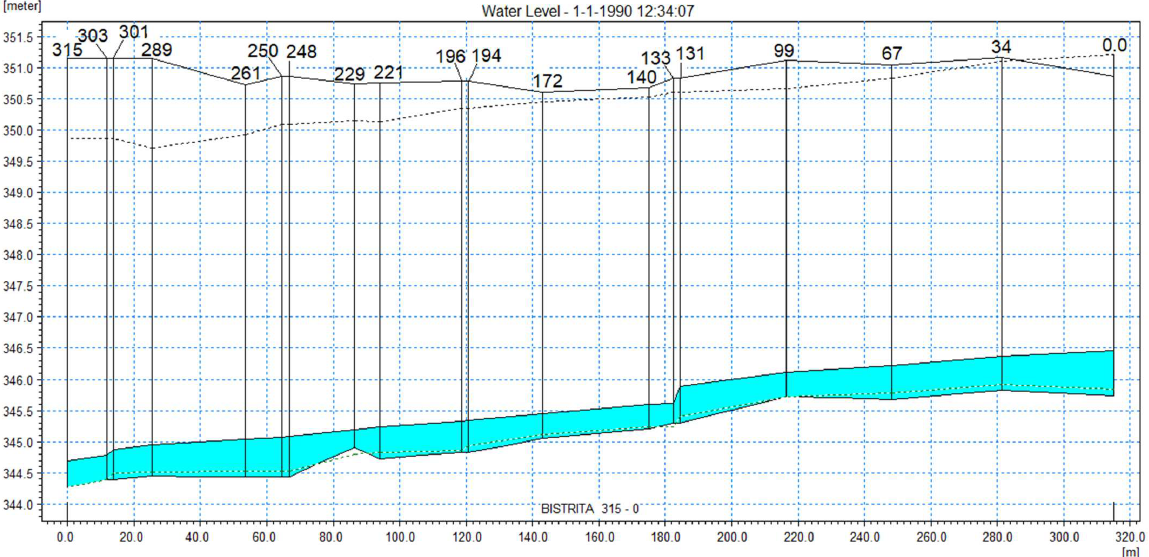
Figure 12. Water level for flow Q = 3.56 m 3 /s, summer flow recorded in June 2022. For the proposed case with the lowering of the crest of the existing weir and the construction of three new weirs of low height downstream of